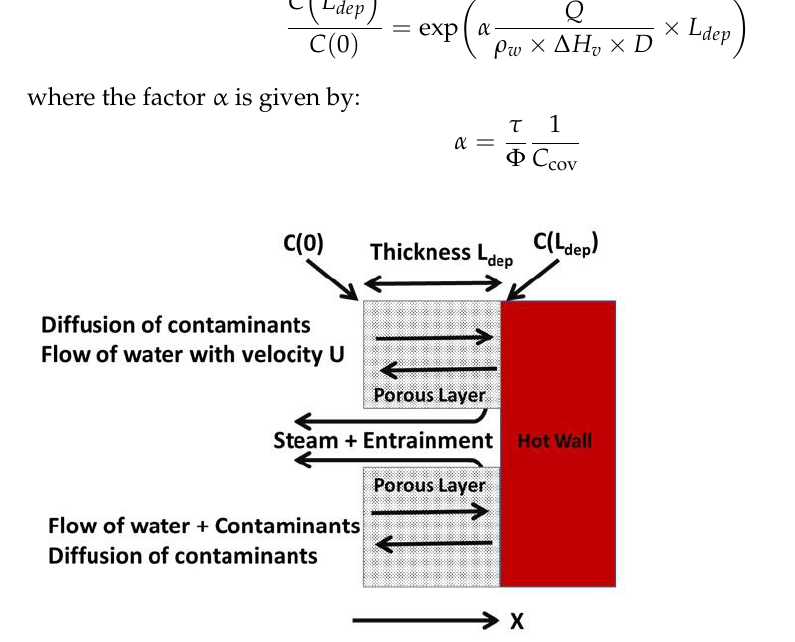
Figure 4. Schematic of the wick-boiling model proposed by Gonzalez and Spekkens [20].